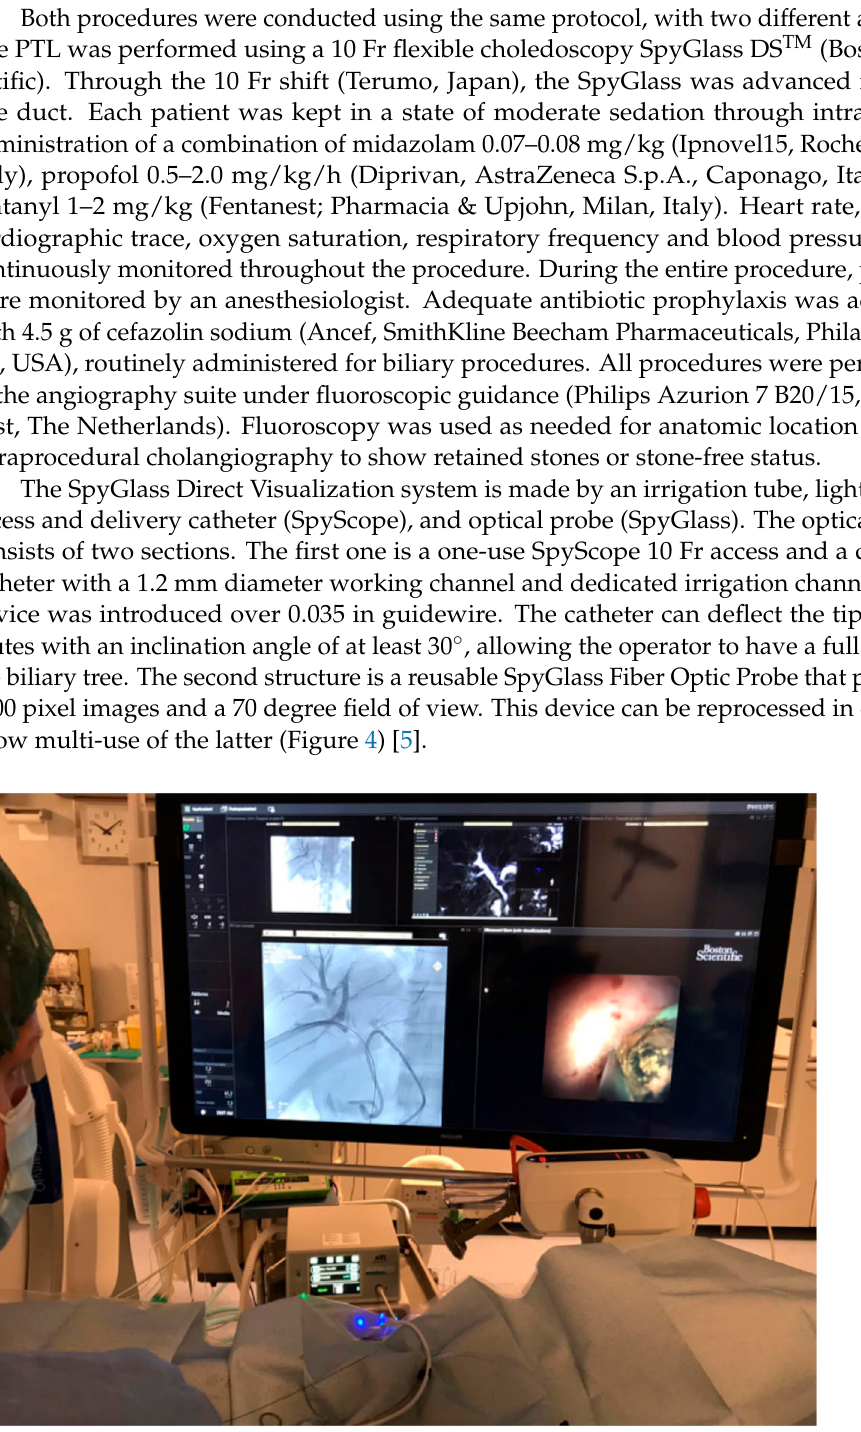
Figure 4. Monitors in front of the operators show fluoroscopic and choledocoscopic images. For fragmenting the stones, an electrohydraulic system is introduced from the dedi- cated canal of the choledoscopy and consists of a bipolar probe and a charge